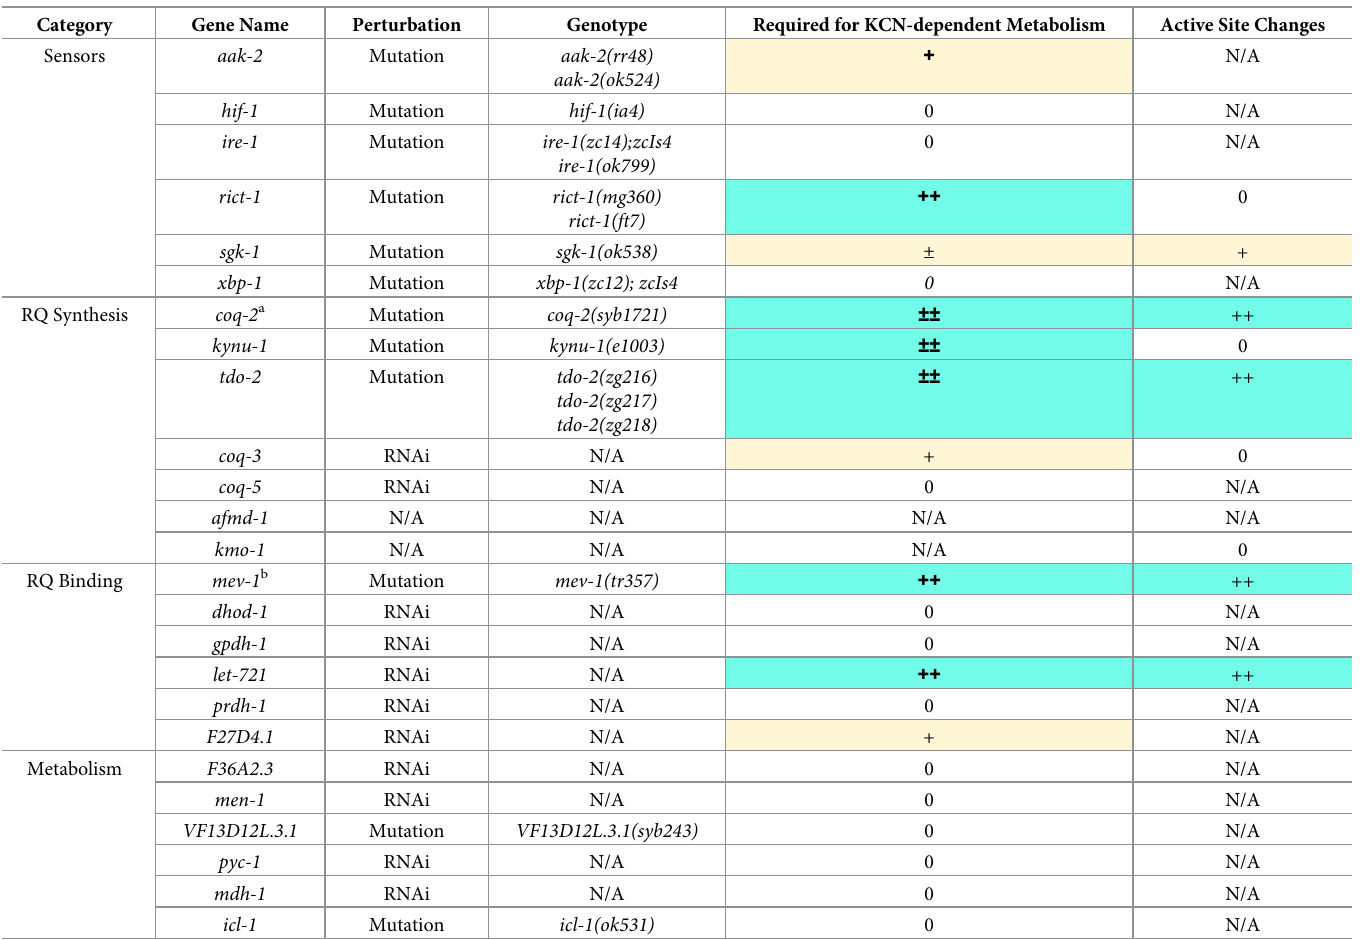
Table 1. Candidate genes with potential roles in RQ-dependent